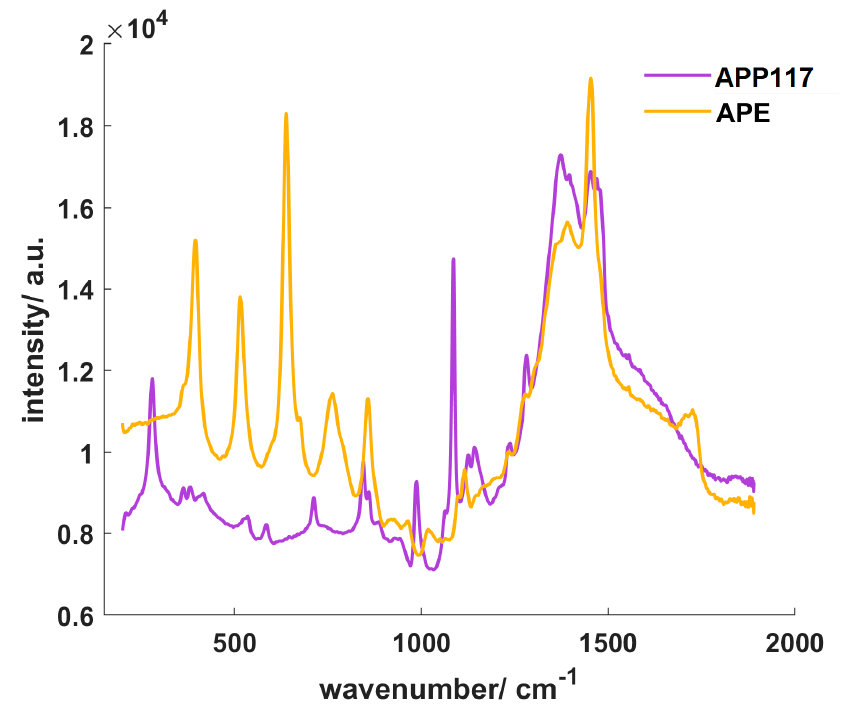
Figure 3. Raman spectra of the different coating layers, APE: AquaPolish ® P white 712.02 E; APP117: AquaPolish ® P white 014.117.